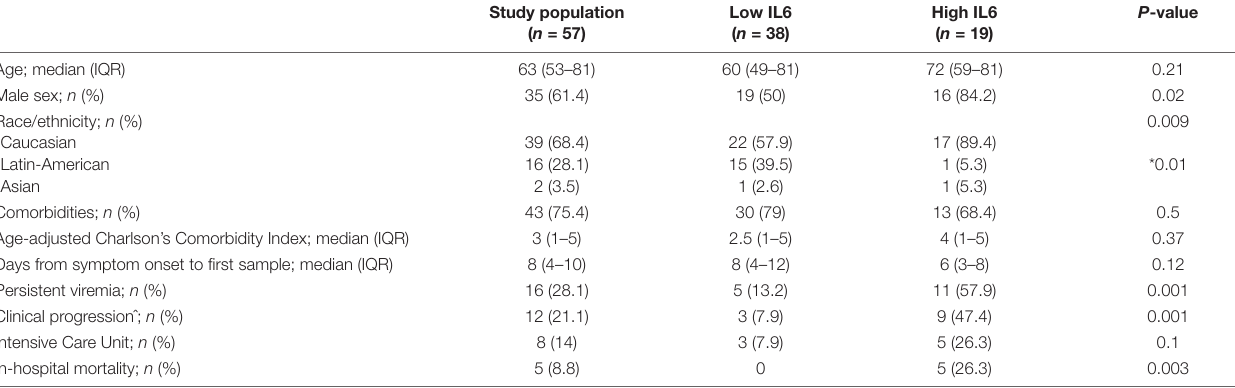
TABLE 1 | Baseline clinical characteristics of the study population according to IL6